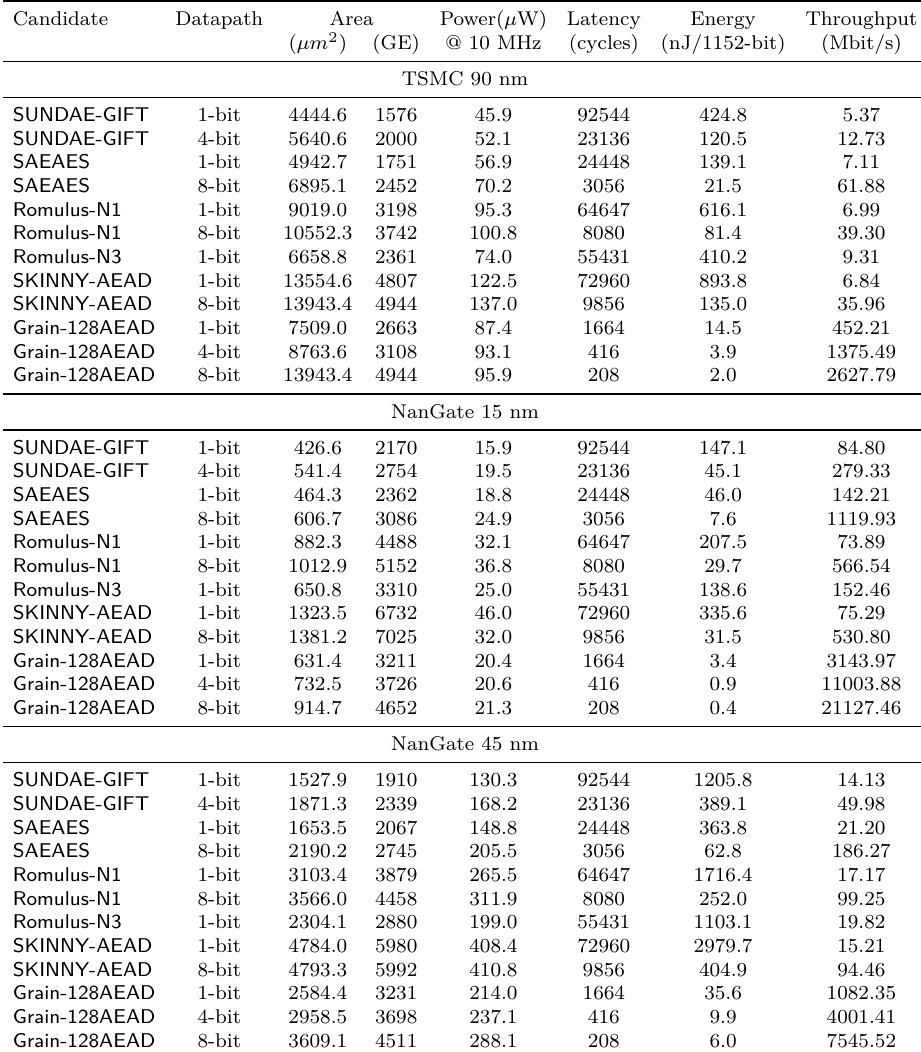
Table 13: Low-latency synthesis figures for selected AEAD Schemes in TSMC 90 nm, NanGate 15nm and 45nm libraries. Energy and throughput are calculated for processing 1024 bits of plaintext and 128 bits of